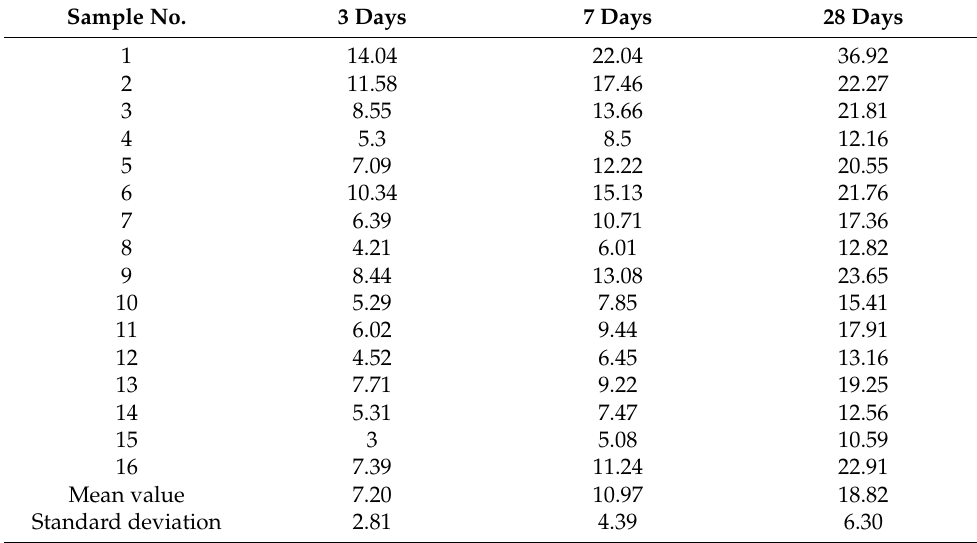
Table 4. Compressive strength of different curing days (MPa). Sample